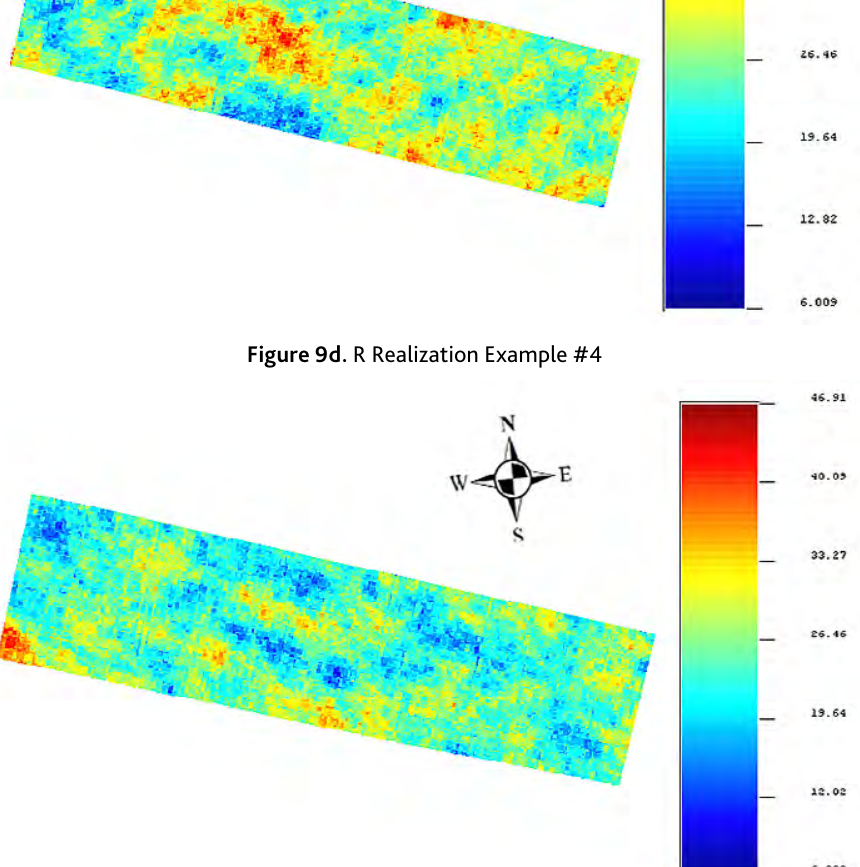
Figure 9e. R Realization Example #5